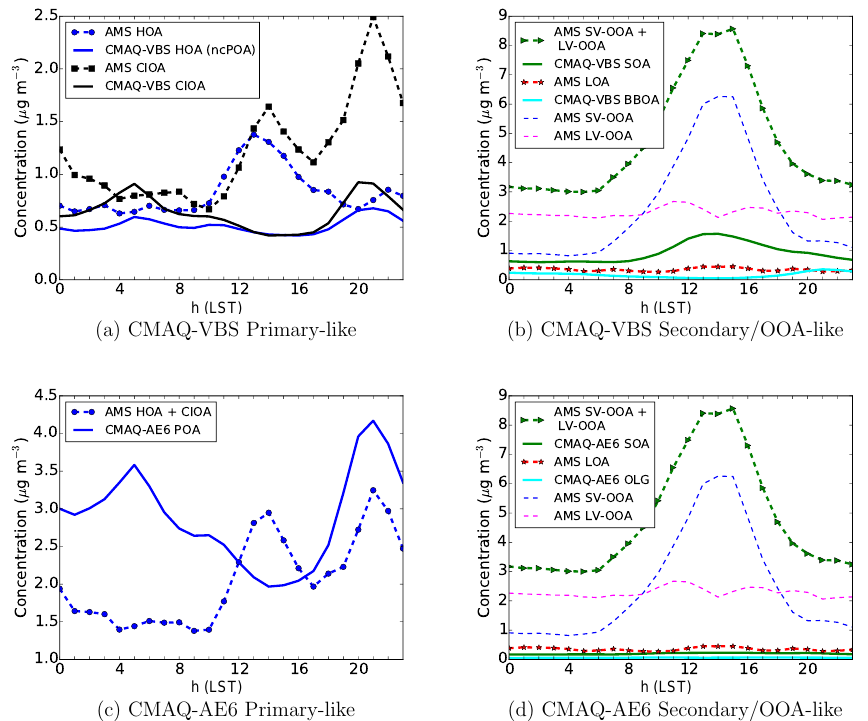
Figure 4. Diurnal profile of AMS-measured PMF OA components against CMAQ-VBS (a, b) and CMAQ-AE6 (c, d) predictions at Pasadena.